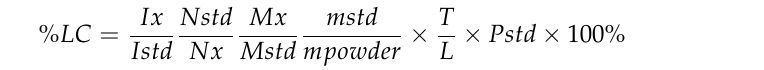
solvents, Table S1:The assignment of 1 H-NMR data of the Orlistat in DMSO- d 6 , Table S2: The integral values of different